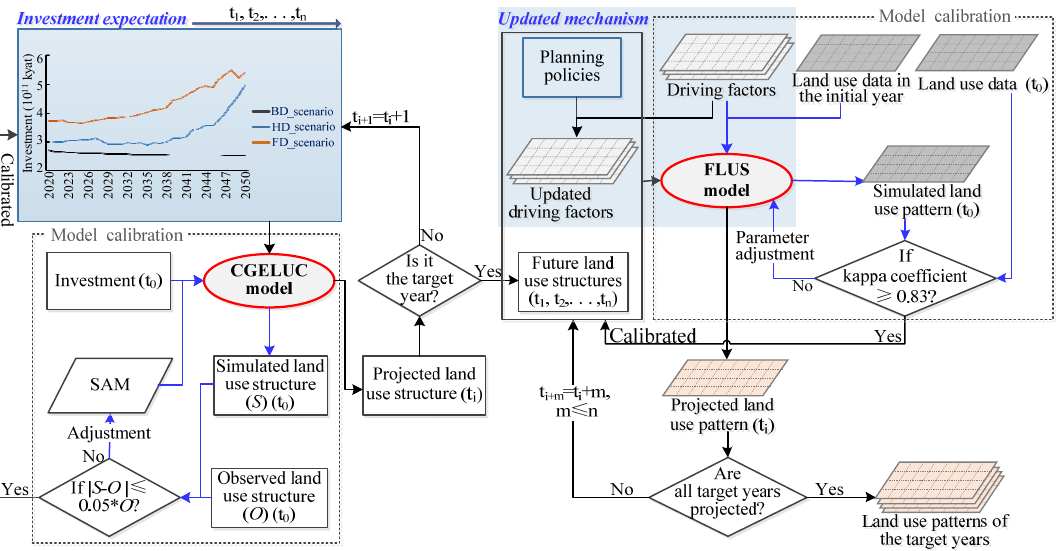
Figure 2. Schematic framework of the proposed coupling model of CGELUC and FLUS. The blue arrows describe the flows of model calibration for the CGELUC and FLUS models , and the black arrows demonstrate the flow of land use projection.